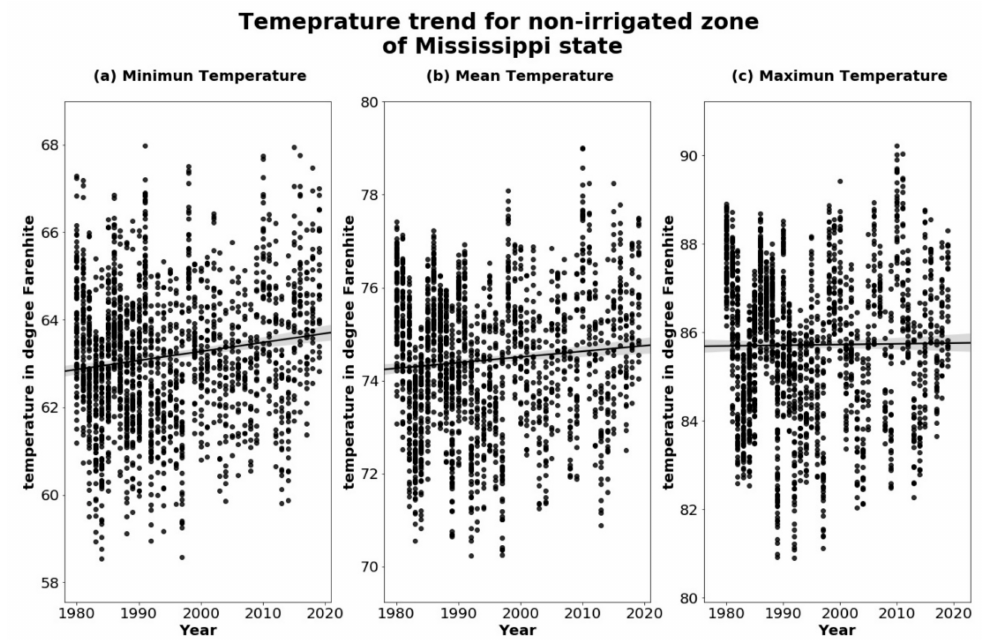
Figure 4. Trends for ( a ) seasonal minimum temperature, ( b ) mean temperature, and ( c ) maximum temperature, trend for non–irrigated zones of the Mississippi State from 1980 to 2019.